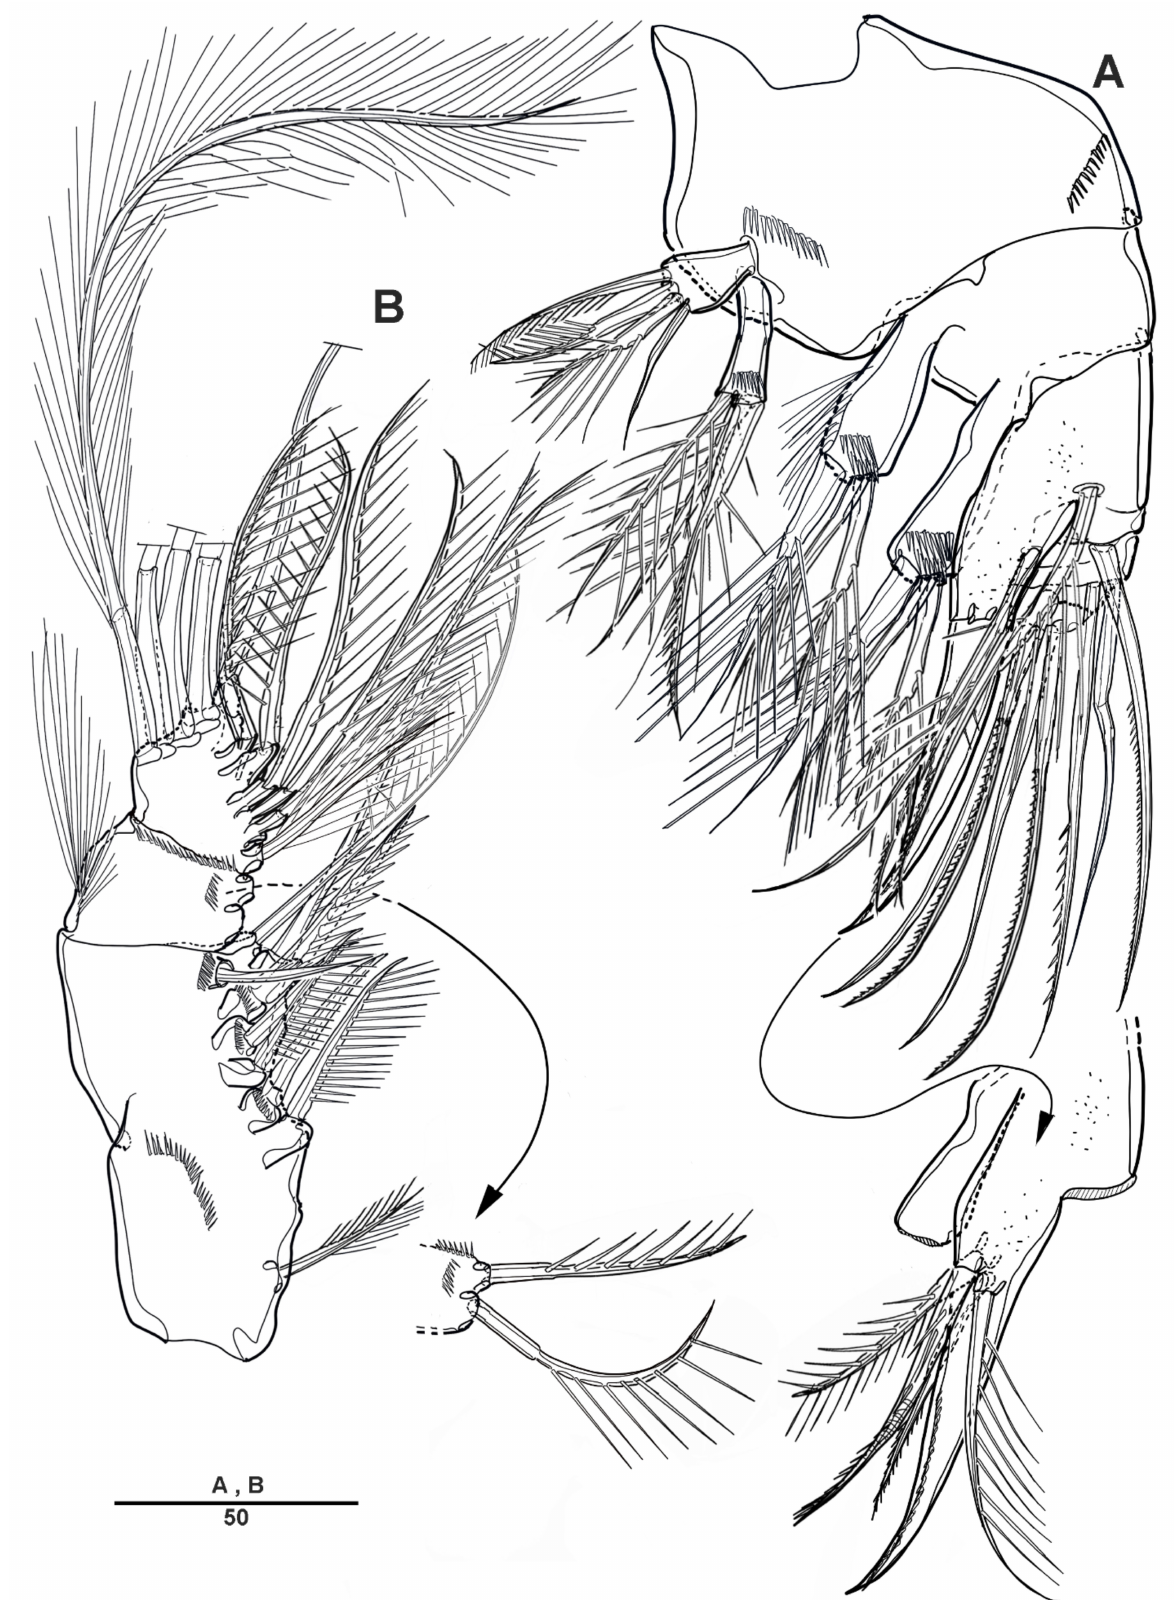
Figure 5. Scottolana daecheonensis sp. nov. holotype female: ( A ) maxilla (inset showing armature on allobasis); ( B ) maxilliped. Scale bars in µ